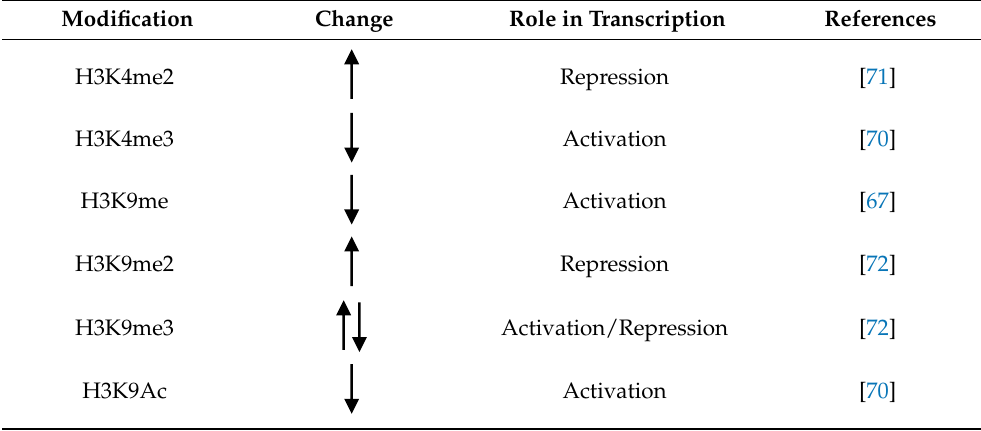
Table 1. Histone modification patterns in association with aging.